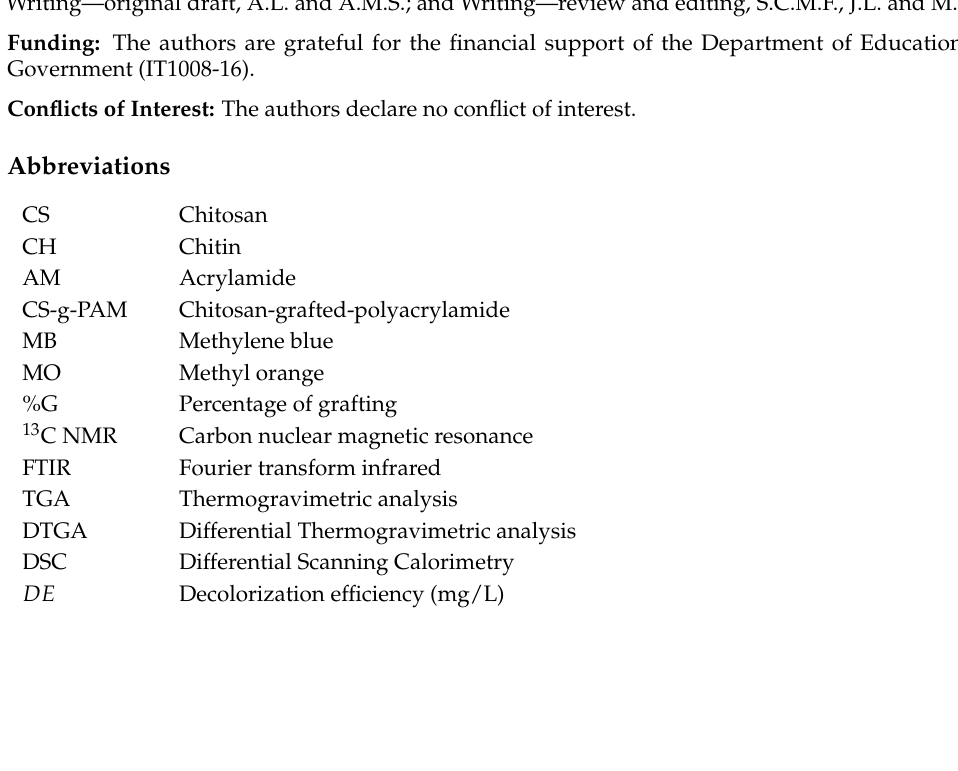
Figure S1. 13 C NMR spectra of chitosan (a) and chitosan-g-polyacrylamide (CS-g-PAM) (b), Figure S2. TGA (a) and DTG (b) spectra of chitosan and chitosan-g-polyacrylamide (CS-g-PAM). Figure S3. DSC spectra of chitosan and chitosan-g-polyacrylamide (CS-g-PAM). Figure S4. SEM micrographs of chitin (a) and chitosan (b); XRD of chitin and chitosan (c). Figure S5. Arrhenius plot of Ln K c versus 1 for the decolorization of MB and T MO by CS-g-PAM and CH: initial MB and MO concentration: 5.0 mg/mL; CS-g-PAM and CH concentration: 0.3 g · 10 mL − 1 (b); plot of ln ( 1 − θ ) versus 1 for the decolorization of dyes solution: initial MB, MO concentration: T 10 mg/L; CS-g-PAM and CH concentration: 0.3 g · 10 mL − 1 at 25 ◦ C